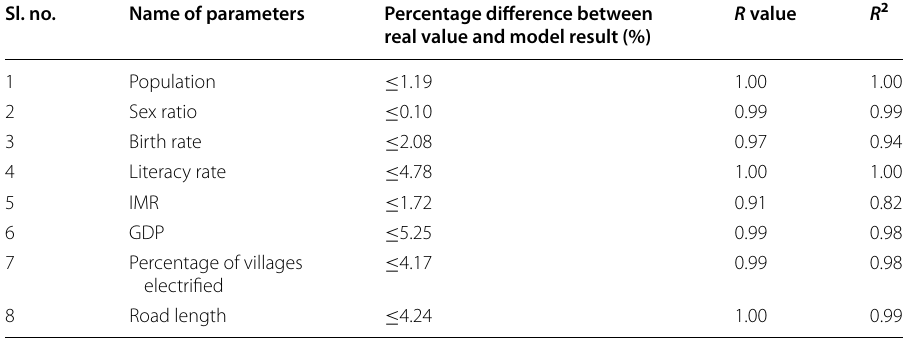
Table 8 Model validation using percentage difference and regression analysis method Sl. no.